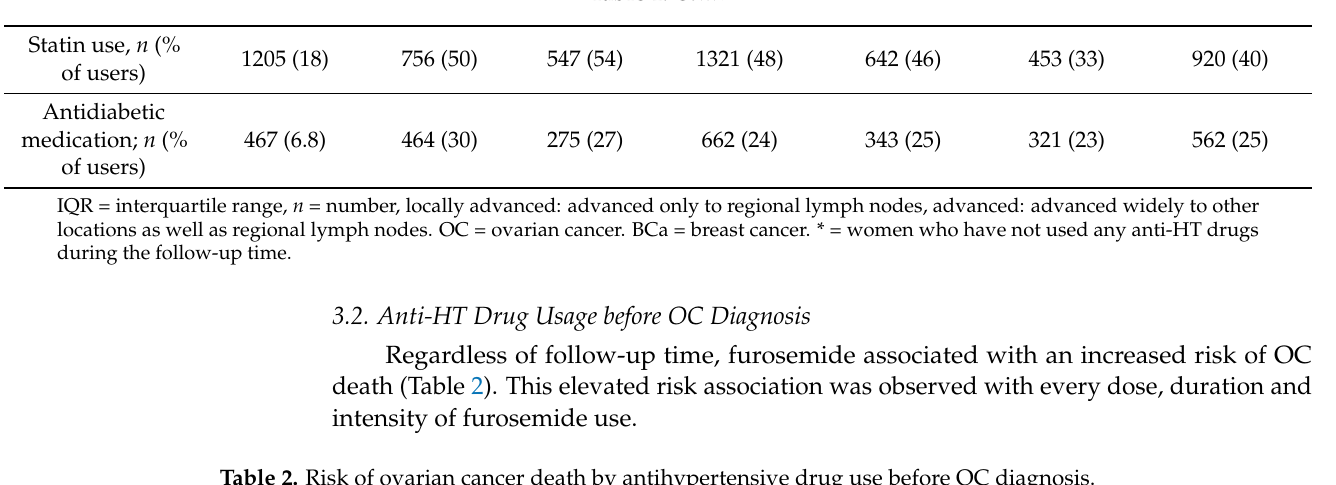
Table 2. Risk of ovarian cancer death by antihypertensive drug use before OC